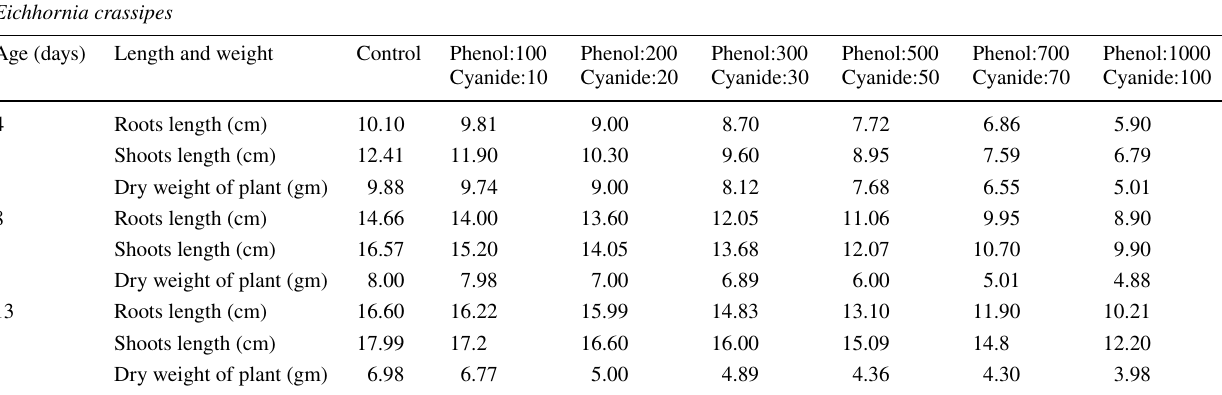
Table 1 Measurement of shoot and root length of the Eichhornia crassipes at different growth period under the treatment of various phenol and cyanide